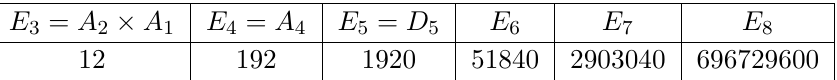
Table 4 . The order of the Weyl group for each exceptional algebra # W ( E n ).